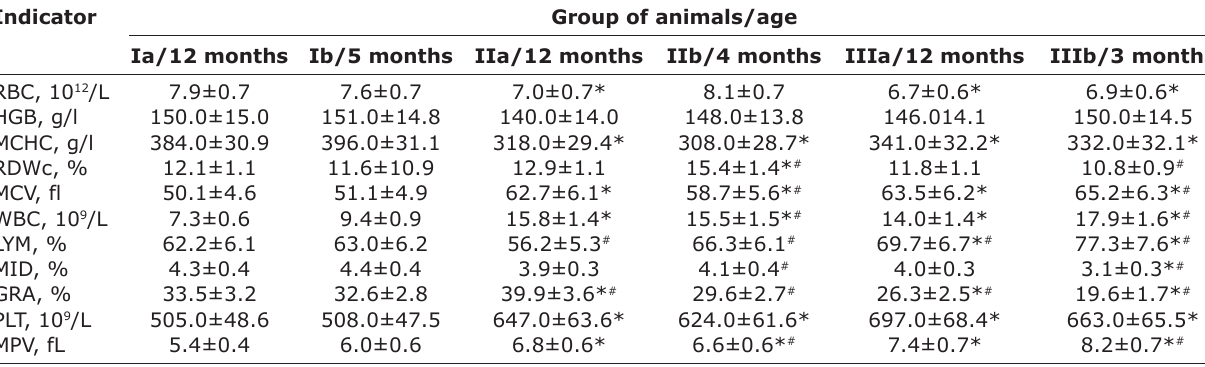
Table-2: Hematological parameters of rats (experiment of 6 months). Indicator